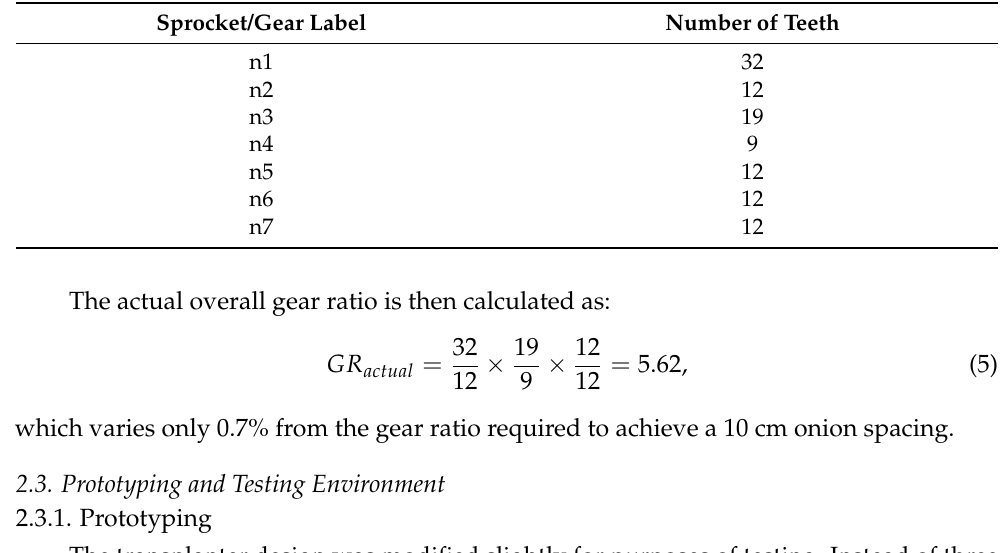
Table 3. Number of teeth for each sprocket/gear of the powertrain.